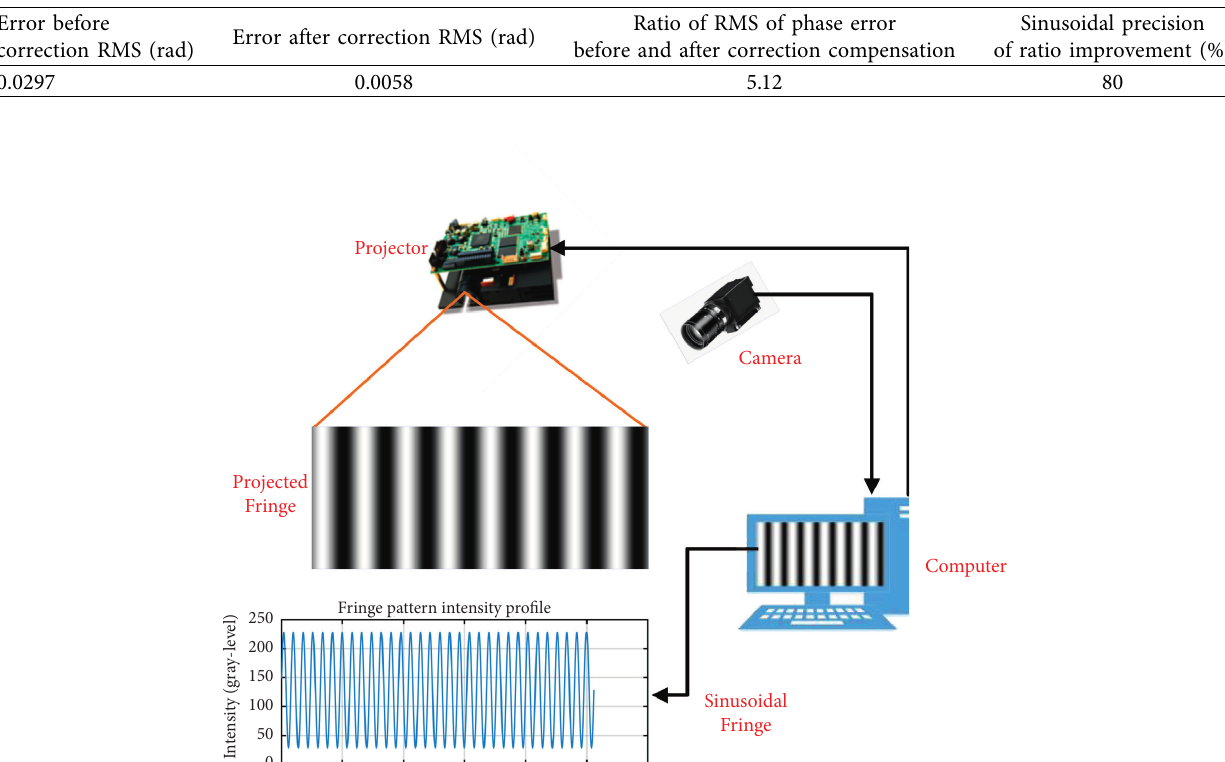
Figure 6: Corrected gamma � 1.3104, spectrum display diagram. Table 1: RMS before and after correction of the gamma coefficient.